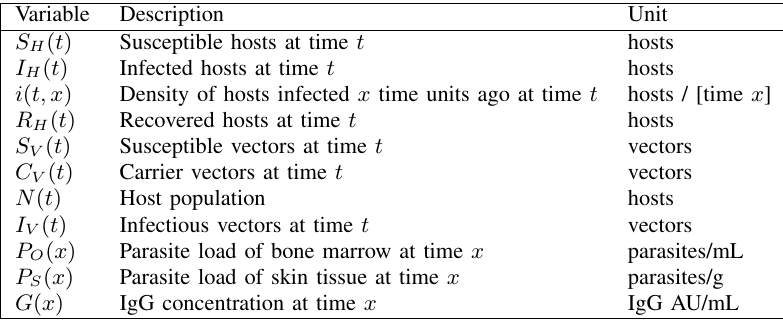
TABLE IV: Definitions of dependent variables.